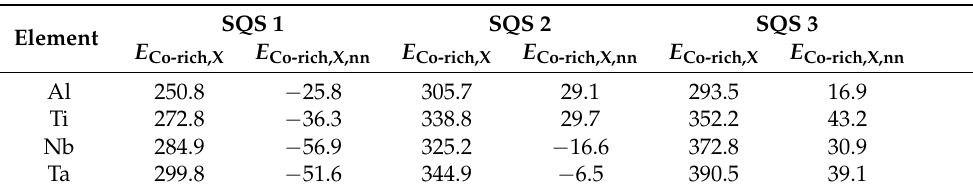
Table 2. Energy E Co-rich to transfer an element from a pure nickel matrix to a matrix containing 25 at-% Co. Additionally shown is the energy E Co-rich,nn that accounts for nearest-neighbor effects. If this number is small, the effect of a Co-rich matrix is mainly governed by nearest-neighbor effects. All energies are given in